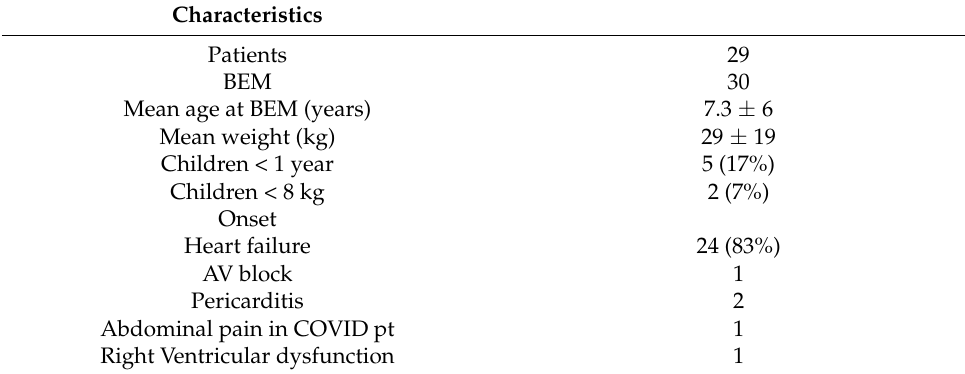
Table 1. Characteristics of our population.